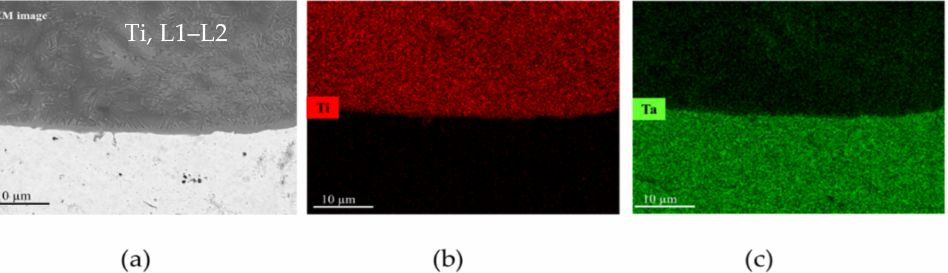
Figure 6. Microstructure of Ti–Ta joint at (L1–L2)–L3, cross section of burned Set 1 (Table 2): ( a ) SEM image of Ti-Ta layer; ( b , c ) EDX mapping of Ti and Ta,